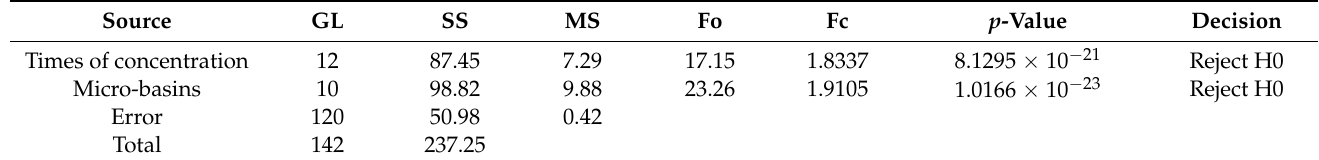
Table 5. Analysis of variance for the times of concentration.